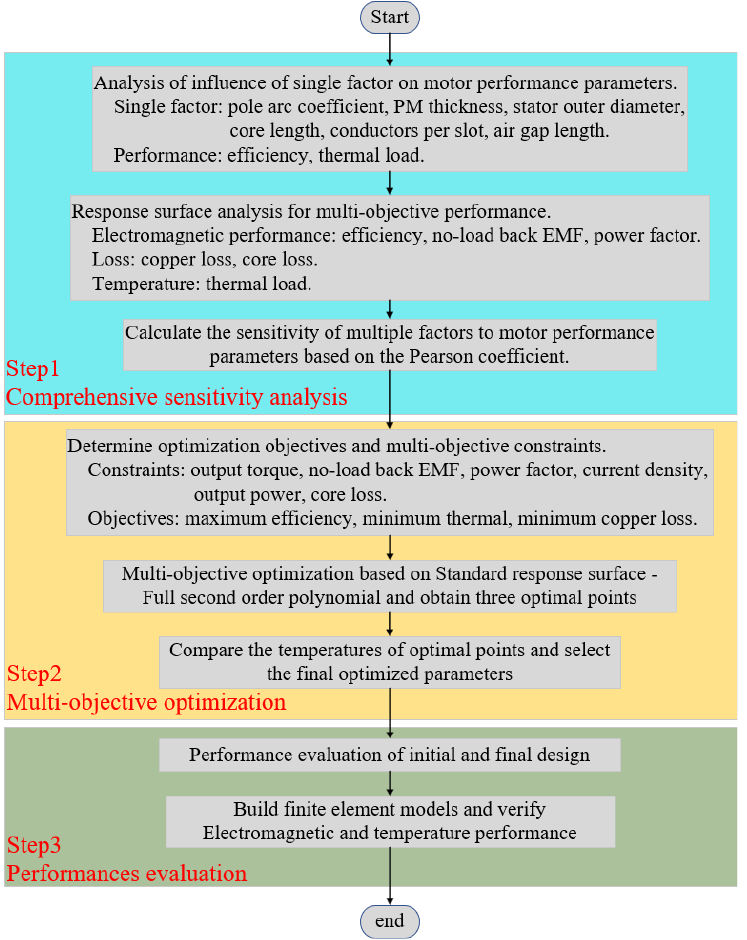
Figure 2. Flowchart of the multi ‐ objective optimization.